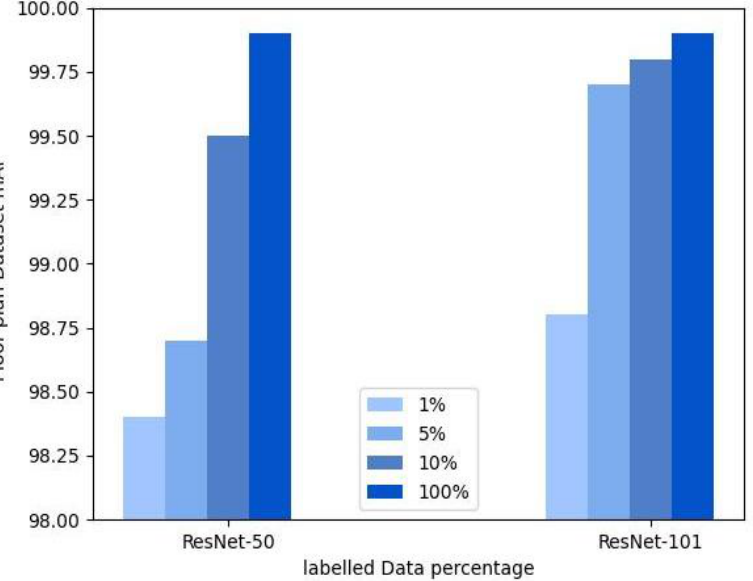
Figure 2. Compares the performance of ResNet-50 [19] with the ResNet-101 backbone network using Mask R-CNN [17] framework under different label data